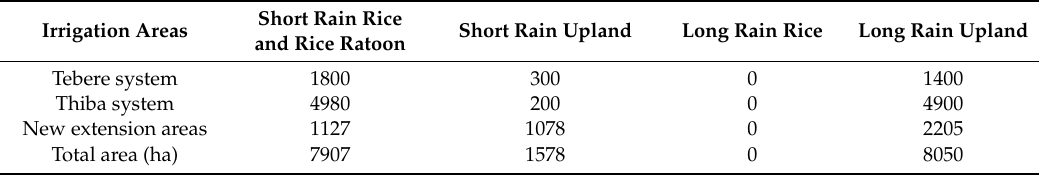
Table 4. Irrigation areas and crops of the proposed cropping pattern. Irrigation